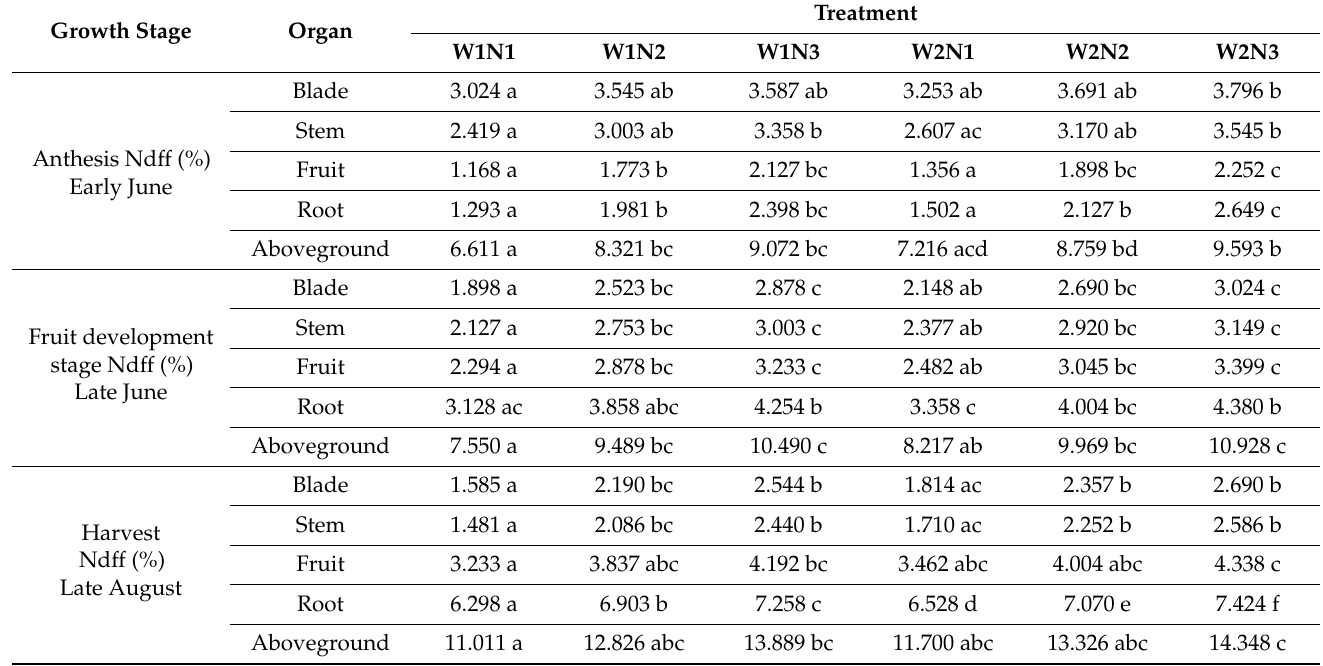
Table 6. Percentage of nitrogen in the grapevines originating from fertilizer nitrogen at different growth stages